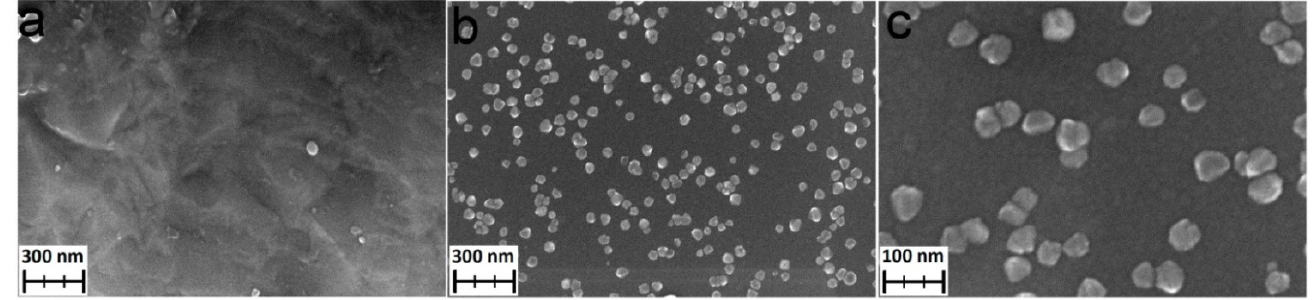
Figure 5. SEM images of TiO 2 coatings deposited on the UFG titanium using TTIP/H 2 O at 200 ° С ( a ) and TiCl 4 /H 2 O at 200 ° С ( b , c